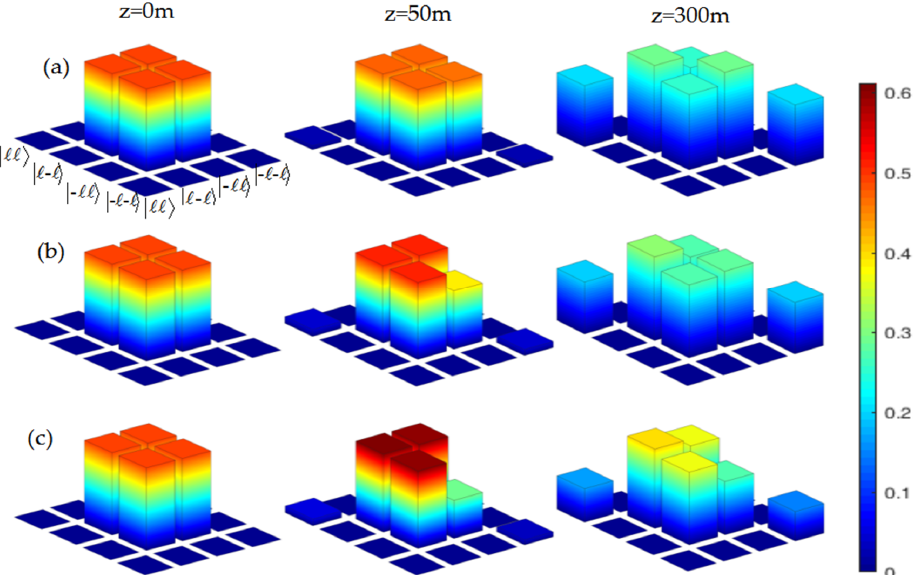
Figure 4. Graphic representations of the density matrices.The diagonal elements of the density matrices are horizontally arranged. ( a ) for (cid:96) = 3, p = 0; ( b ) for (cid:96) = 3, p = 1; ( c ) for (cid:96) = 3, p =